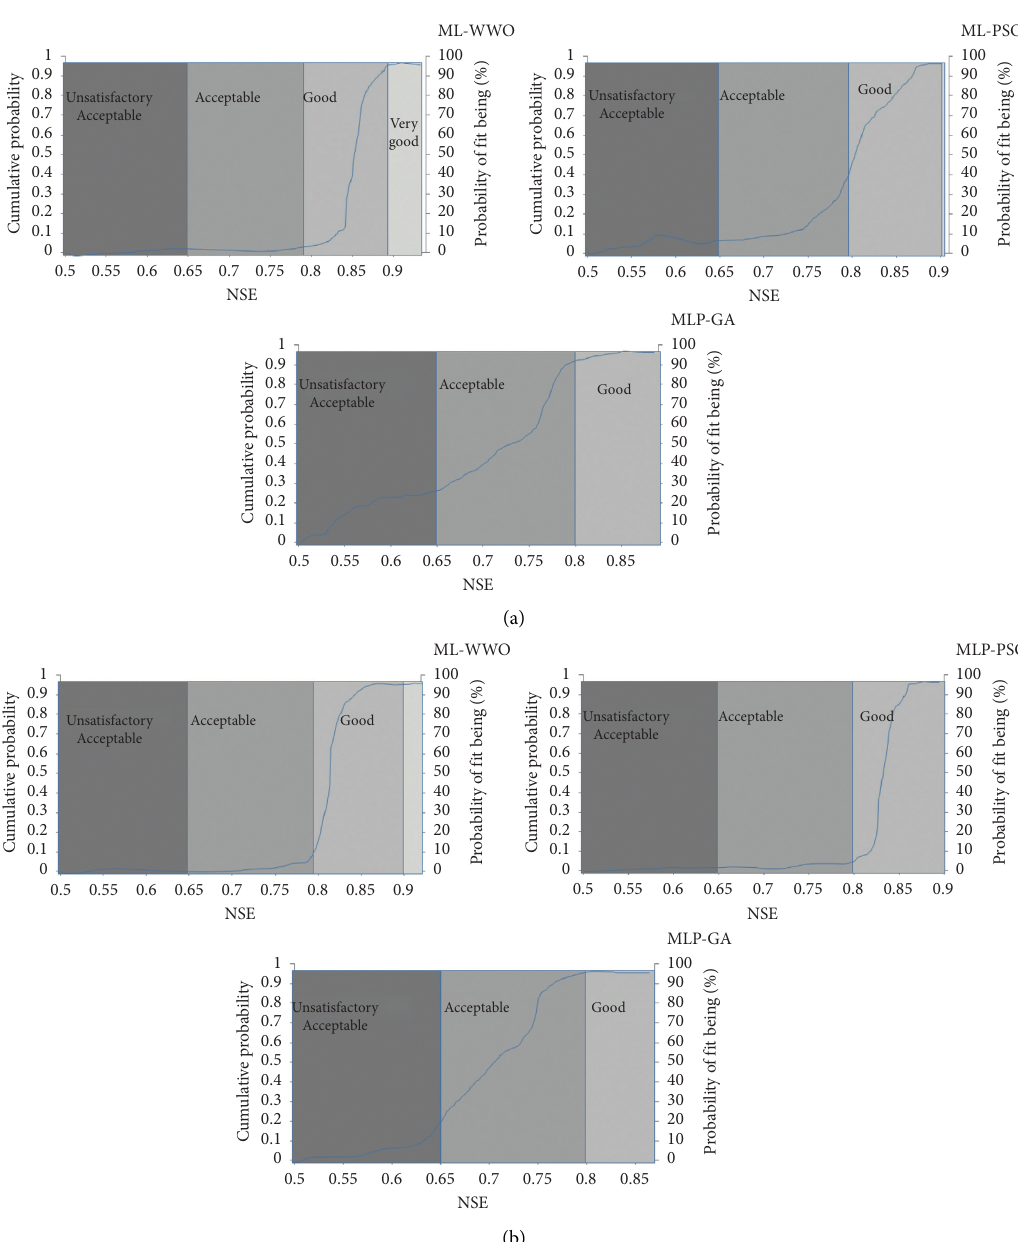
Figure 11: The probability distribution for NSE: (a) daily ET and (b) monthly